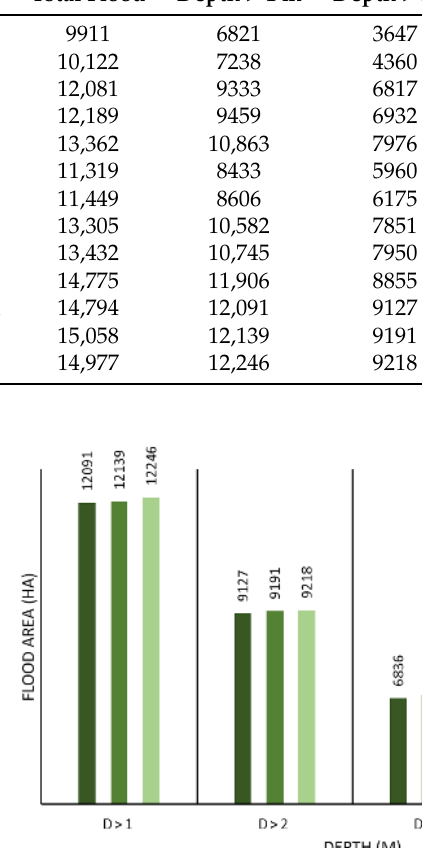
Figure 11. Extension of flood areas with flood depths greater than 1, 2, 3 and 4 m, for Scenarios A–C. Units in